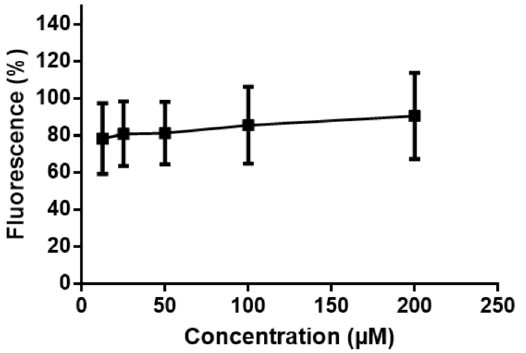
Figure 5. Fluorescence of HaCaT cell line exposed to 1,2-DHX ( 1 ; 12.5, 25, 50, 100, and 200 µM) as determined by the DCFH-DA assay. Data are presented as mean ± SD ( n = 3) relative to solvent control = 100 ± 1.7 ( n = 3). Data were analyzed using one-way ANOVA with a Dunnett post hoc test.